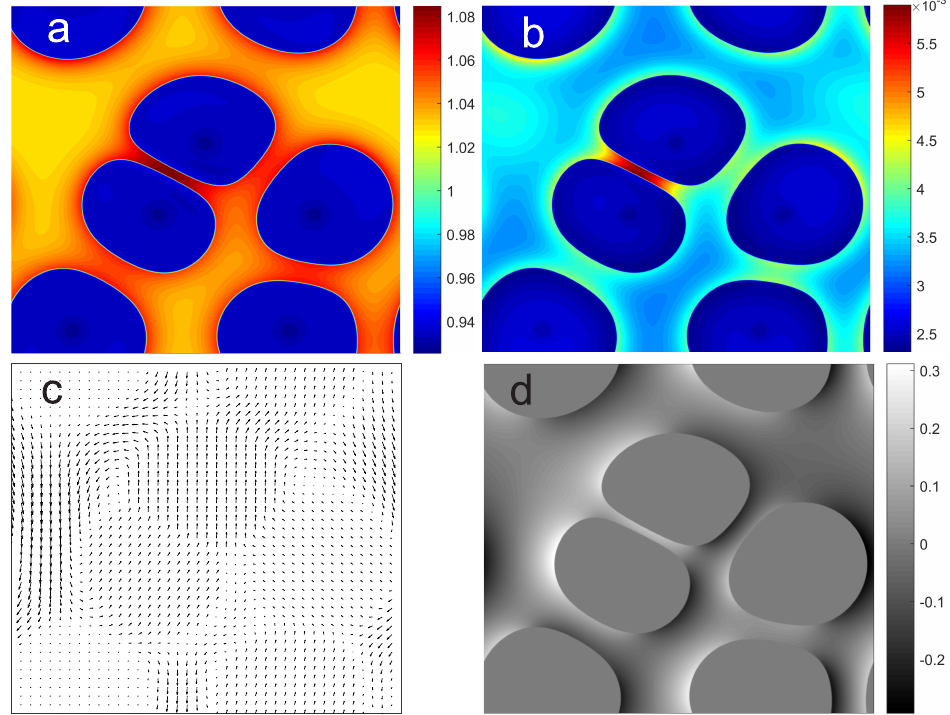
Figure 3. Computational results in addition to Figure 2 at time instant (cid:101) t = 1.5: ( a ) local density (cid:101) ρ adjusted by temperature and solute concentration, ( b ) dimensional liquid viscosity µ (cid:96) (unit Pa s, a dimensional value here for convenience), which is raised by higher solute concentration and lower supercooled temperature, ( c ) scaled velocity (cid:101) v for the fluid flow driven by interfacial blowing and the gravity effect, and ( d ) scaled vorticity field corresponding to the velocity